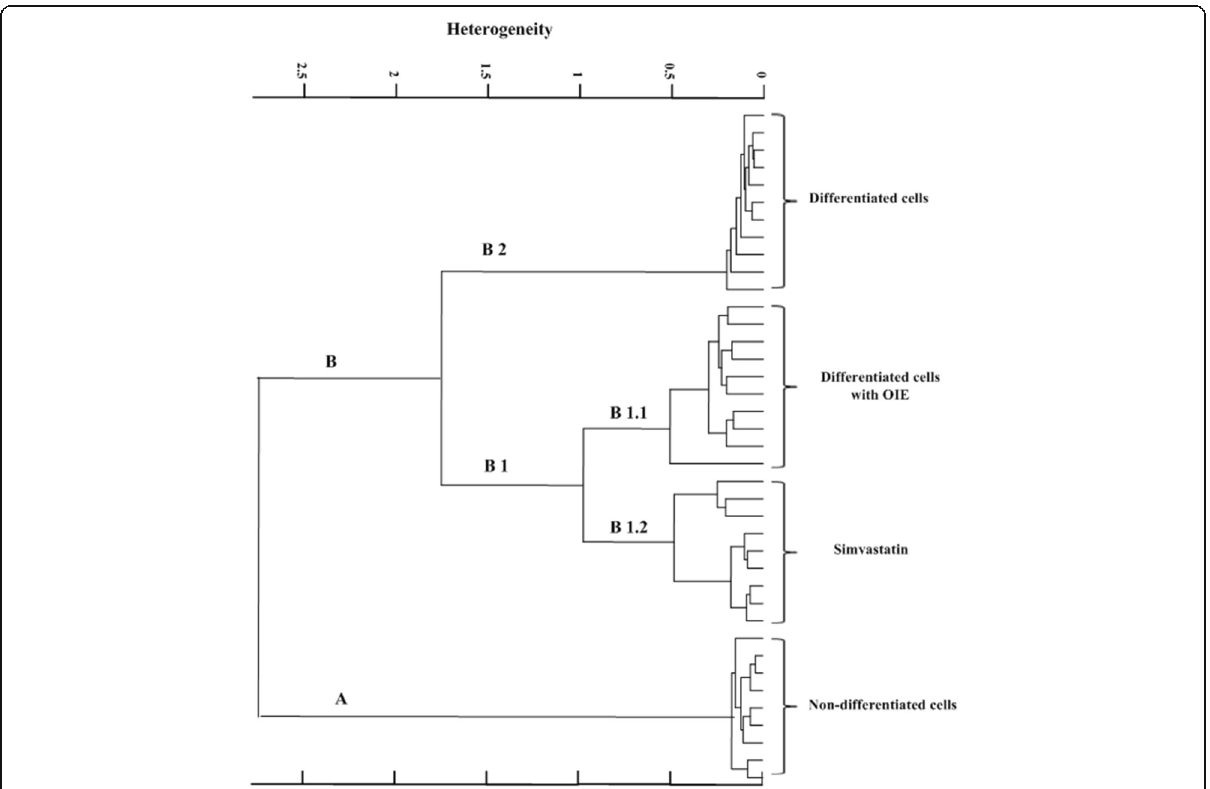
Fig. 9 Unsupervised hierarchical cluster analysis (UHCA) dendrogram achieved by cluster classifications of infrared spectra of 3T3-L1 cells. Non- differentiated cells (pre-adipocytes), differentiated cells, simvastatin- and Oroxylum indicum extract-treated differentiated cells using second derivative spectra data set. The diagram indicates distinct differences between non-differentiated and differentiated adipocytes. It also demonstrates a difference between OIE treated and non treated